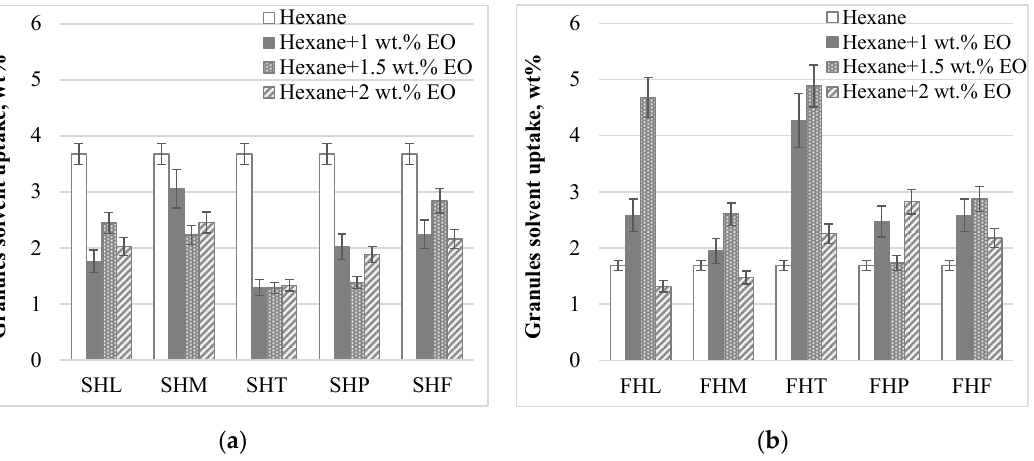
Figure 3. Solvent uptake in hexane at different concentration of essential oil: ( a ) 4043D granules; ( b ) 3D850 granules.